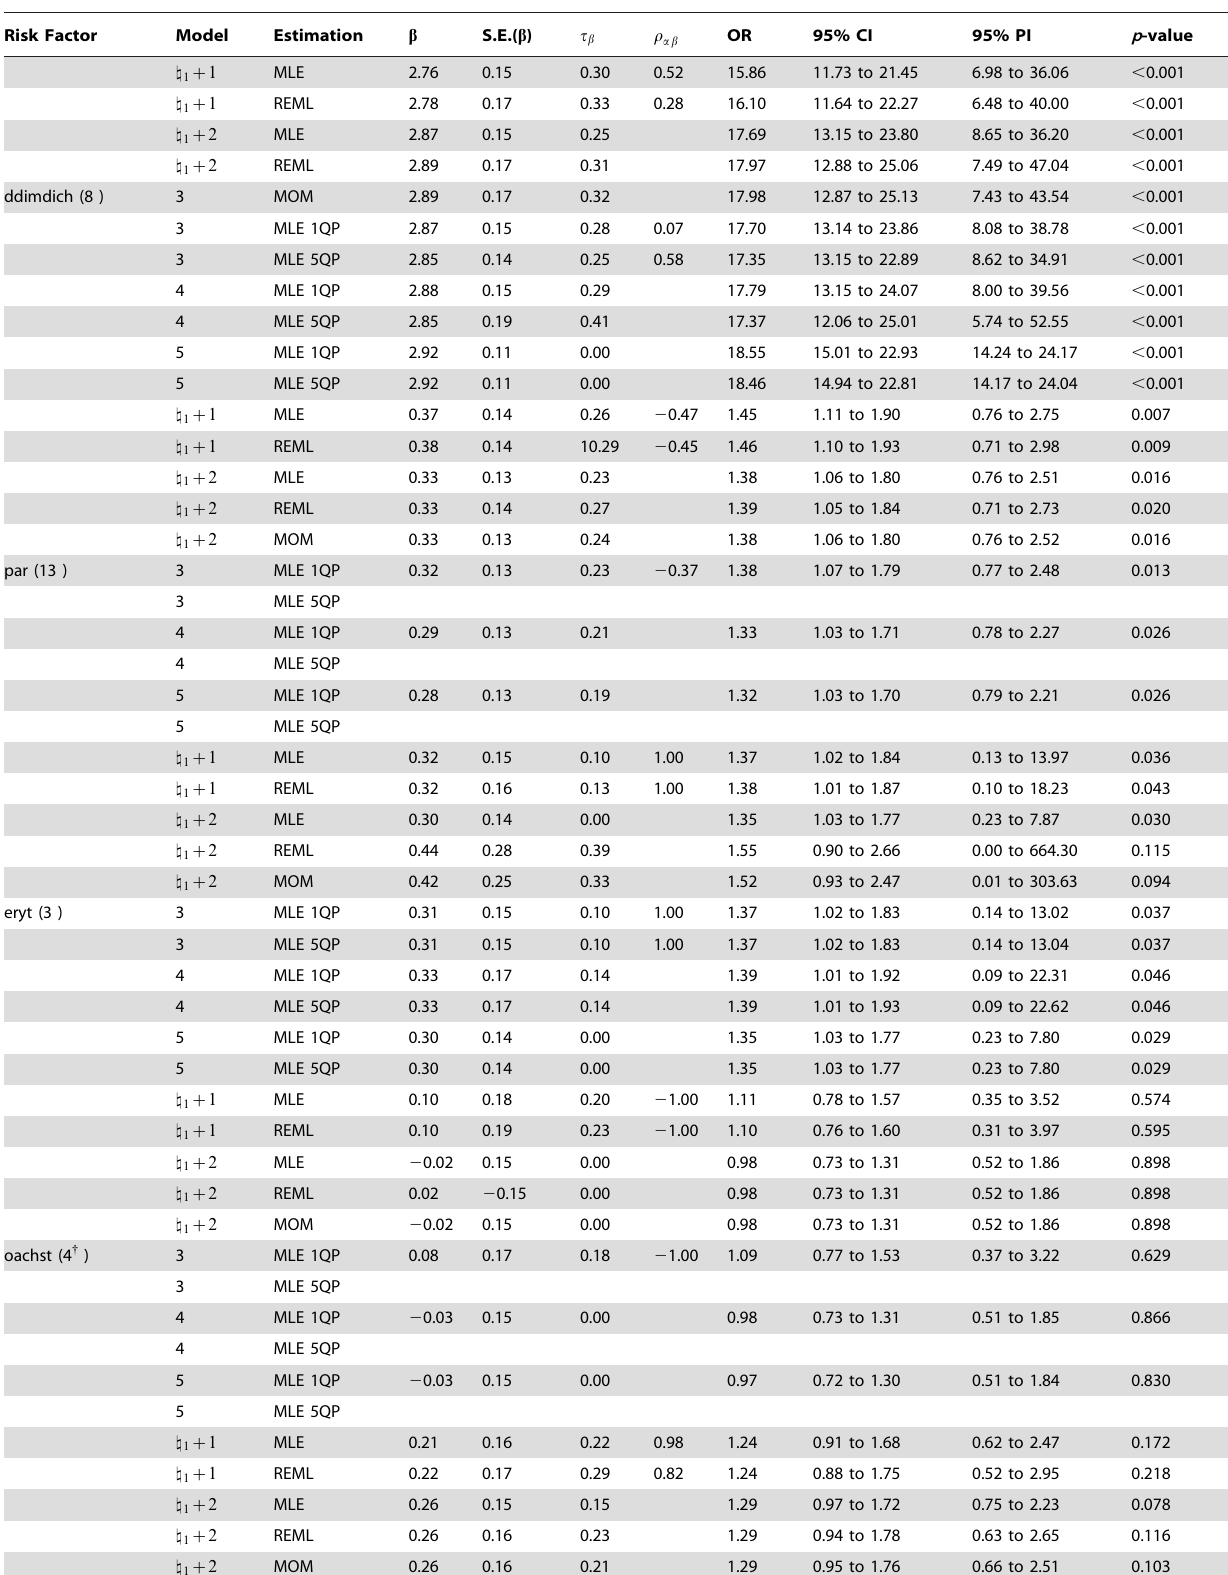
Table 2. Estimated unadjusted factor-outcome associations for the DVT case study.